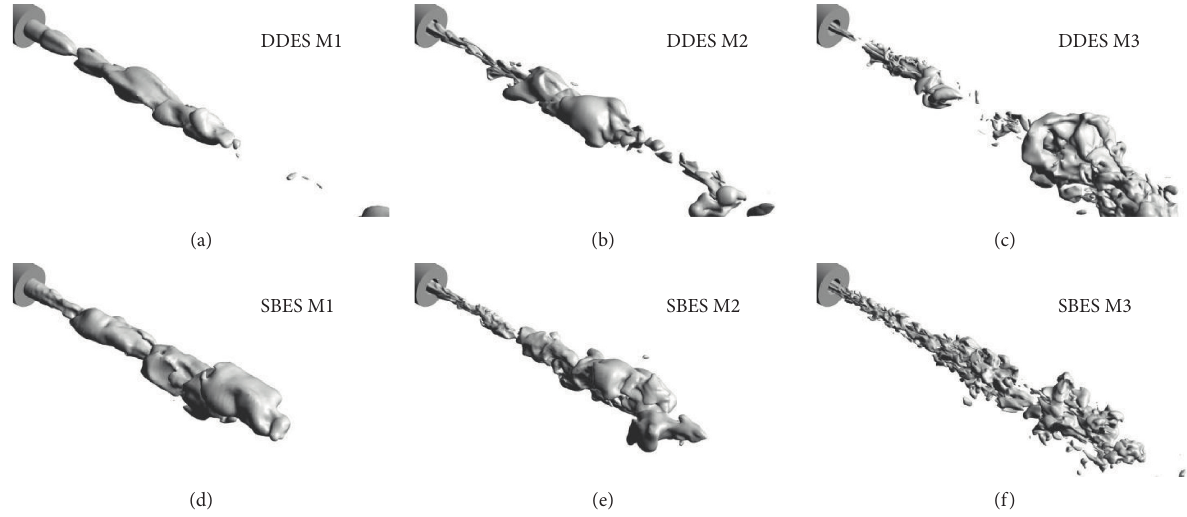
Figure 8: Shape of vapor with different meshes and turbulence models.